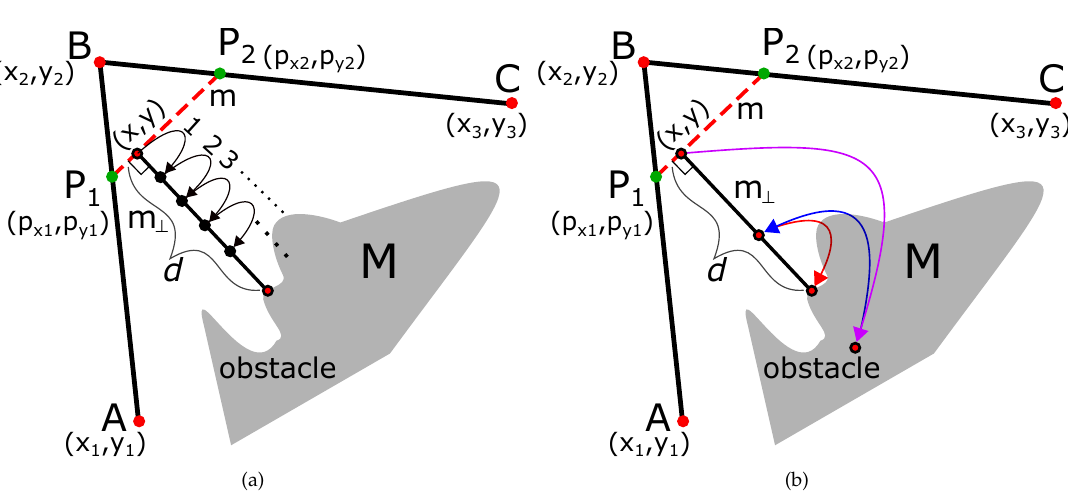
Figure 4. Normal and accelerated calculate of minimum distance from the obstacle. ( a ) normal approach; ( b ) accelerated